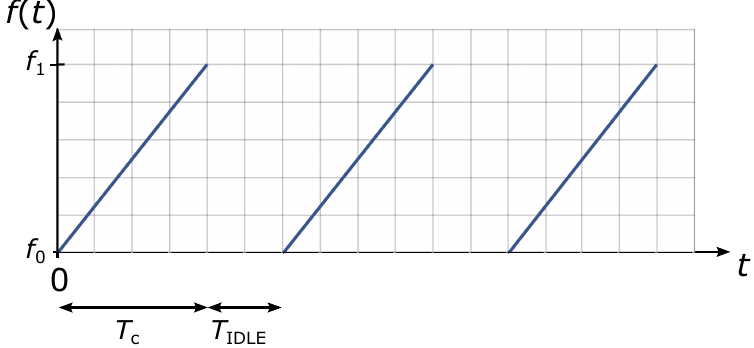
Figure 6. Idle time of the